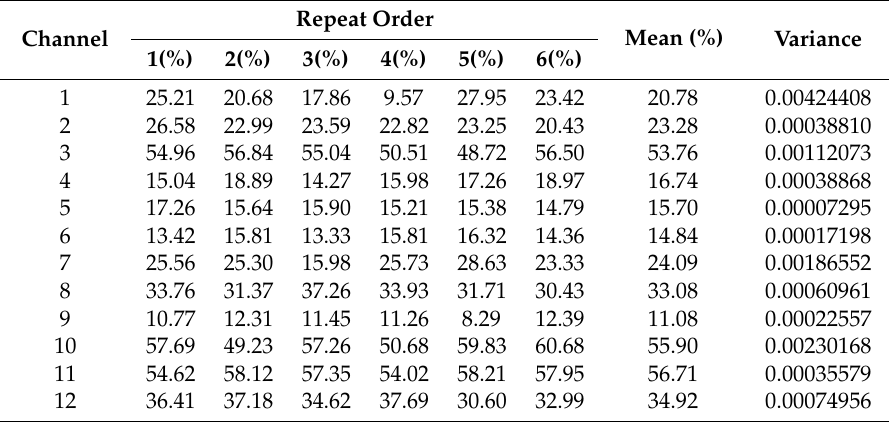
Table 4. Fault diagnosis results using BPNN model with all the twelve channels data.